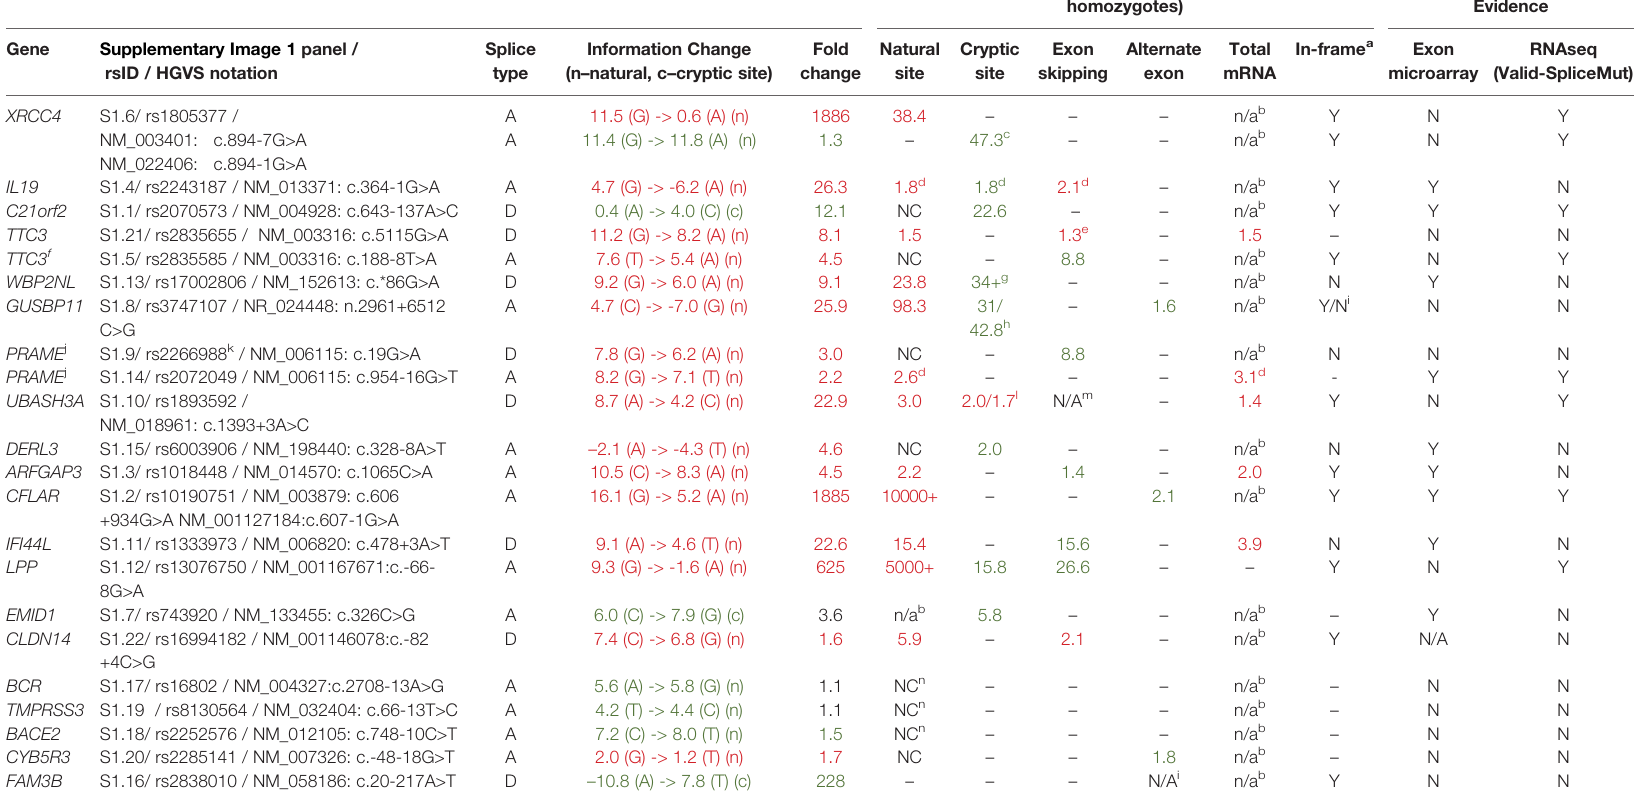
TABLE 1 | Summary of q-RT-PCR